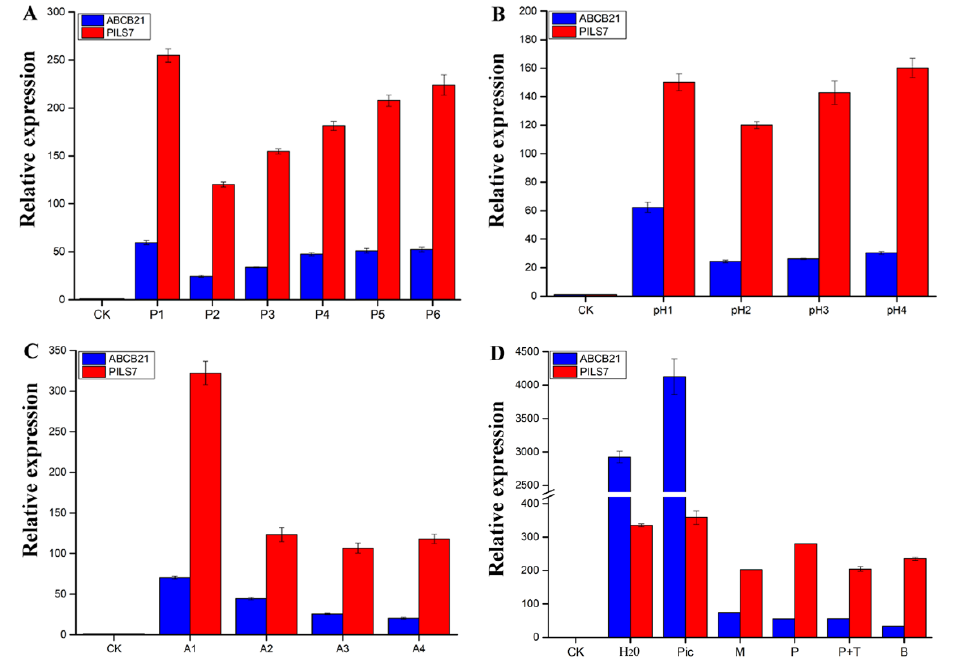
Figure 9. Expression pattern analysis of ABCB21 and PILS7 under different treatments for 3 days. ( A ) The expression of ABCB21 and PILS7 under different concentrations of PIC; ( B ) The expression of ABCB21 and PILS7 under different pH; ( C ) The expression of ABCB21 and PILS7 under different media compositions; ( D ) The expression of ABCB21 and PILS7 under different hormones. CK, untreated scales; H 2 O, water; Pic, water supplemented with PIC at 1.0 mg / L; B, MS media supplemented with 6-BA at 1.5 mg / L; P + T, MS media supplemented with PIC at 1.0 mg / L and 2,3,5-triiodobenzoic acid (TIBA) at 1.0 mg / L; M, MS media; P, MS media supplemented with PIC at 1.0 mg / L; P1–P6, MS media supplemented with PIC at 0.5, 1.0, 2.0, 3.0, 4.0 and 5.0 mg / L, respectively; pH1–pH4, MS media supplemented with PIC at 1.0 mg / L, with the pH adjusted to 4.8, 5.8, 6.8 and 7.8, respectively; A1, MS media without macroelements but supplemented with PIC at 1.0 mg / L; A2, MS media without microelements but supplemented with PIC at 1.0 mg / L; A3, MS media without iron salts but supplemented with PIC at 1.0 mg / L; A4, MS media without organic substances but supplemented with PIC at 1.0 mg / L; All the media were adjusted to pH = 5.8 by 1 M NaOH except pH1 and